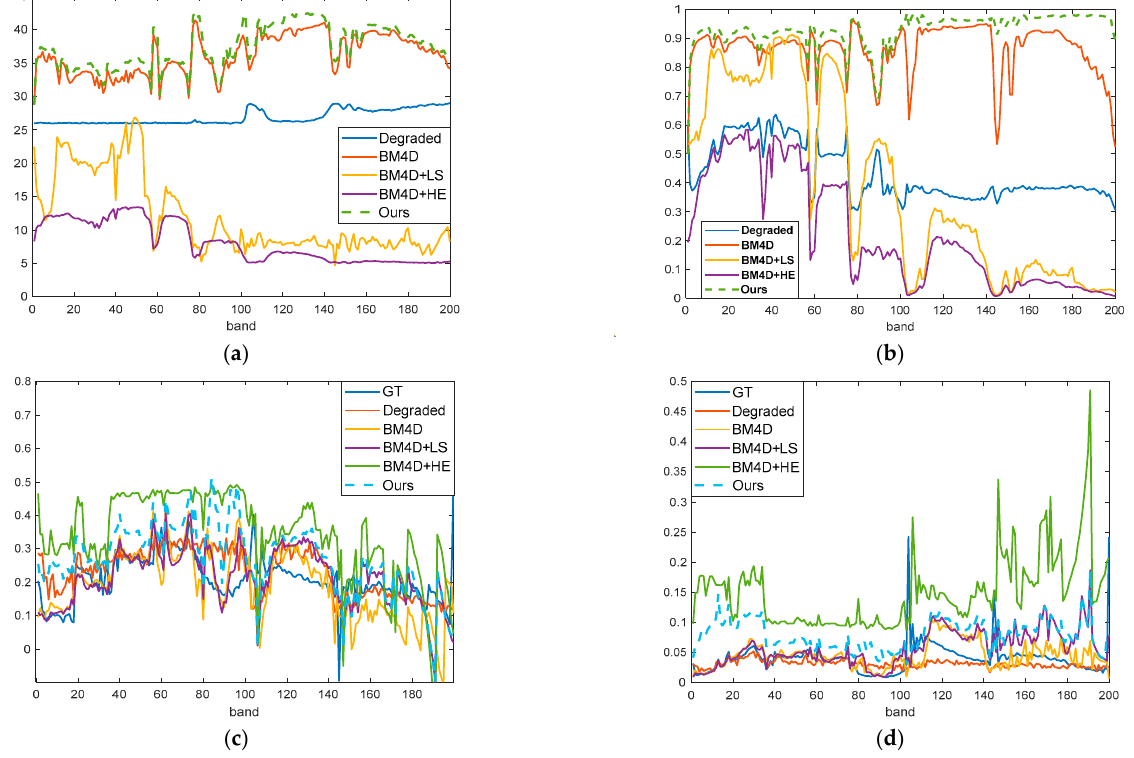
Figure 10. Index curves for each band of the Indian Pines dataset. The blue, red, yellow, purple, and dotted green represent each band’s index with degraded data, BM4D, BM4D + LS, BM4D + HE and proposed results, respectively. ( a ) PSNR evaluation. ( b ) SSIM evaluation. ( c ) Brightness evaluation. ( d ) Contrast evaluation.